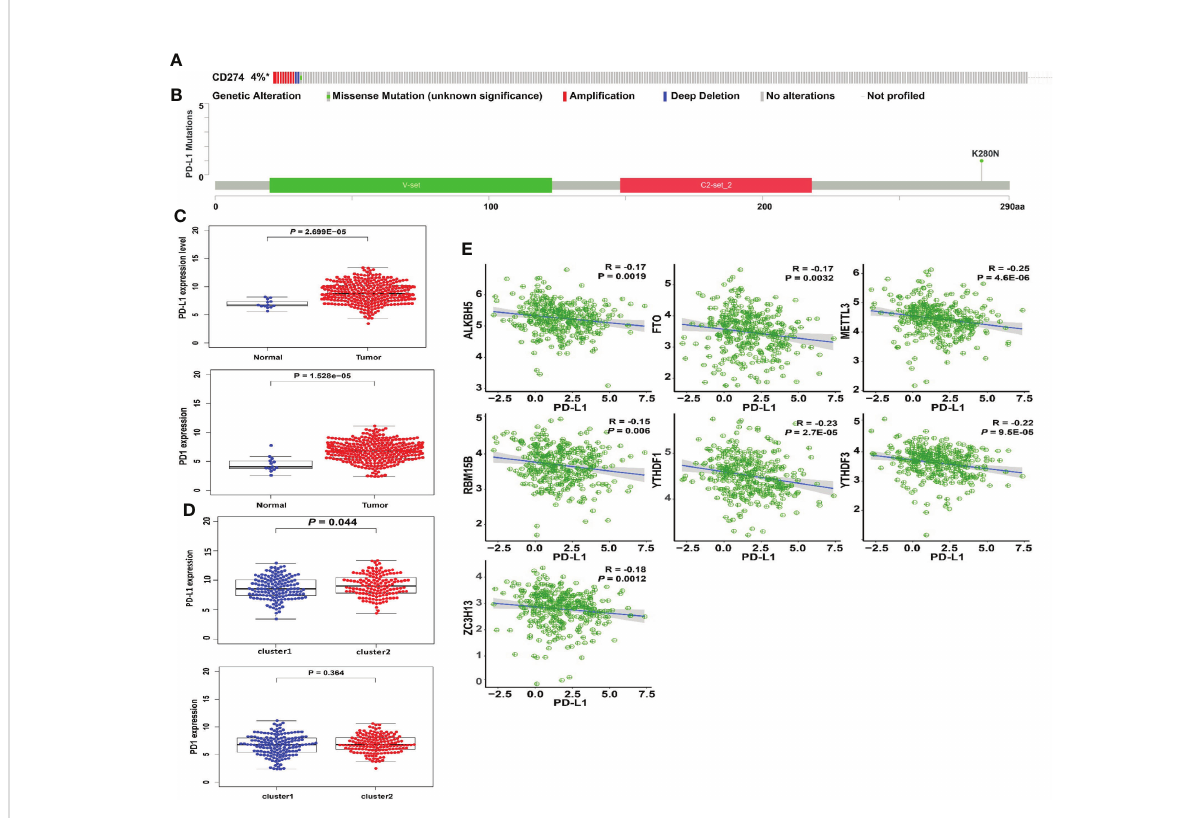
FIGURE 5 Association of PD-L1 with m6A RNA methylation and the landscape of immune cell in fi ltration in cervical cancer. (A) OncoPrint of PD-L1 alterations in the TCGA-CESC cohort identi fi ed by cBioPortal. (B) Lollipop of PD-L1 alterations in the TCGA-CESC cohort identi fi ed. (C) PD-L1 expression was signi fi cantly higher in cervical cancer than that in controls. (D) The expression level of PD-L1 in cluster 1/2 subtypes. (E) The correlation of PD-L1 with m6A methylation regulators in cervical